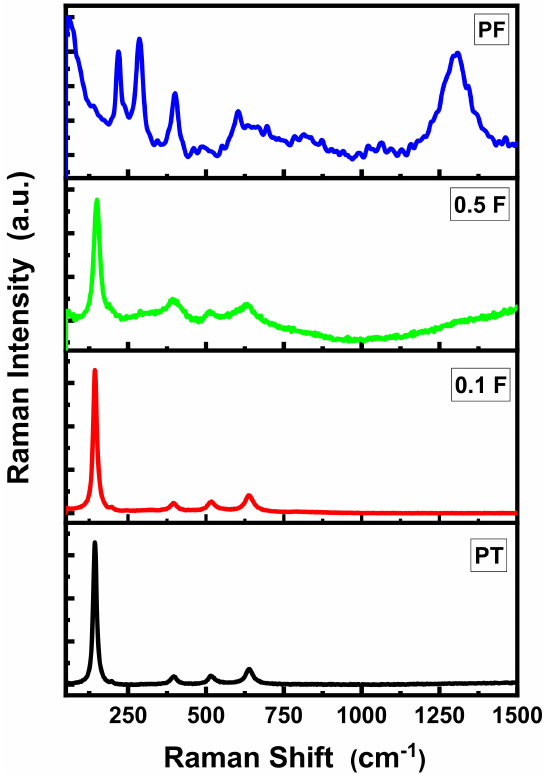
Figure 3. Raman spectra for (TiO 2 ) 1 − x (Fe 2 O 3 ) x